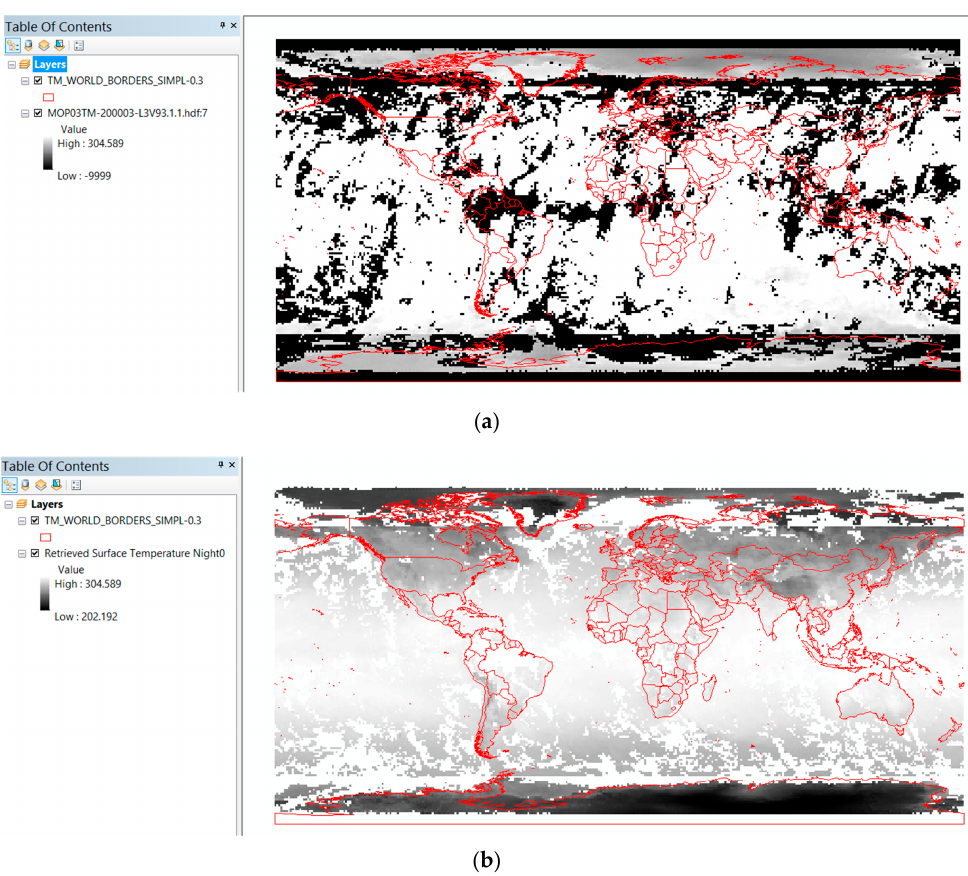
Figure 14. Color scale including No-data value –9999 ( a ) and excluding No-data value ( b ) by incorporating the enhanced GDAL.